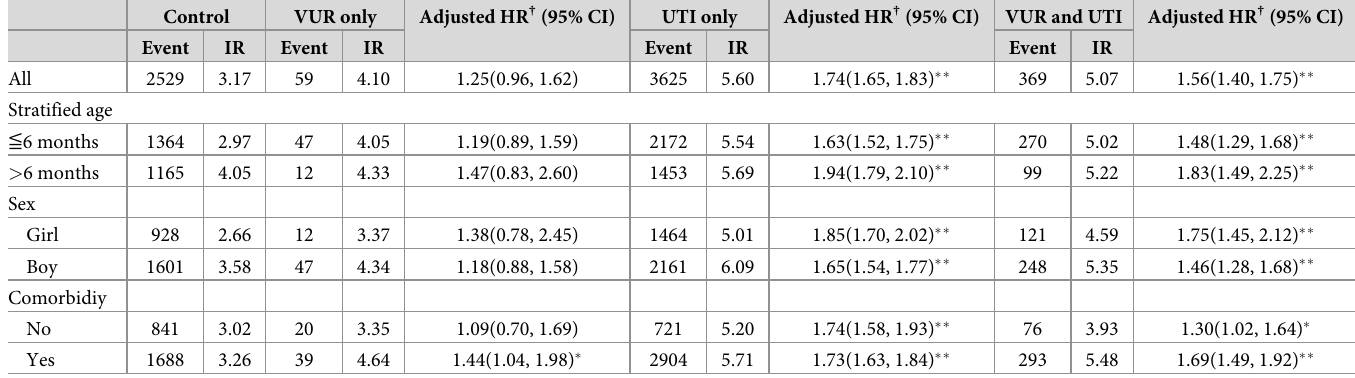
Table 3. The risk of asthma among children with vesicoureteral reflux (VUR), urinary tract infection (UTI) and VUR and UTI compared to control stratified by demographics in Cox proportional hazard regression.